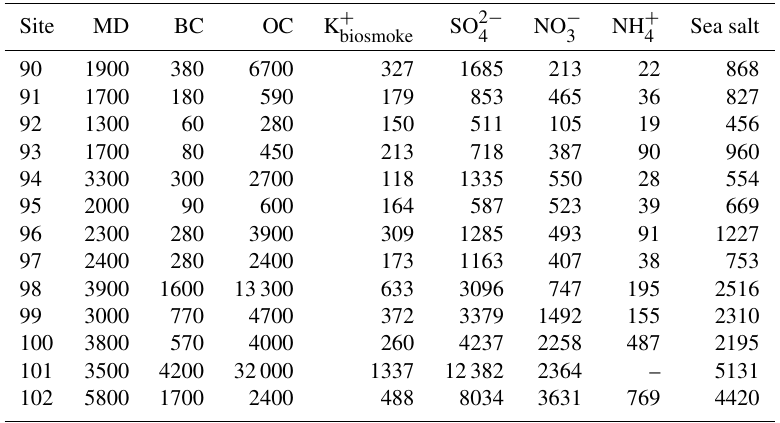
Table 2. Chemical species (ngg − 1 ) in surface snow for sites across northeastern China in January 2014. The datasets of SO 2 − NH + were reprinted from Wang et al. 4